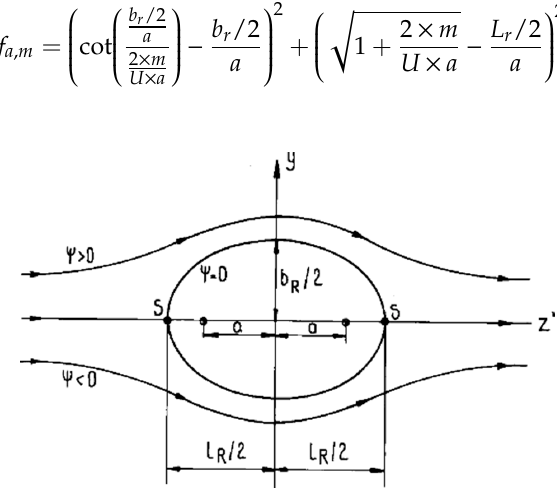
Figure 7. Rankine oval stream function around an elliptical object [14].